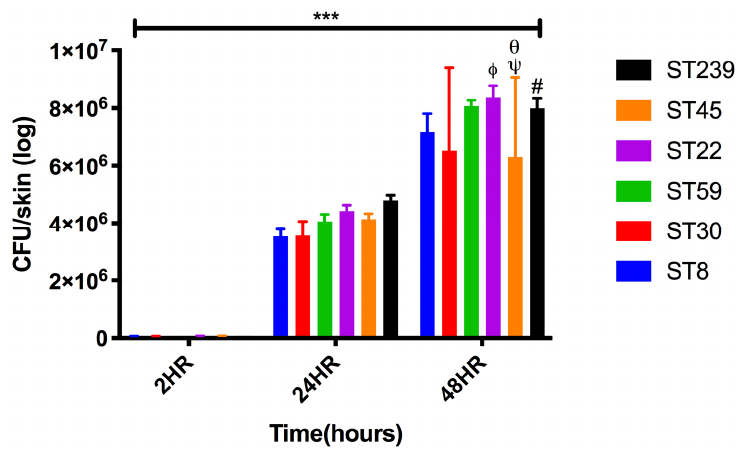
Figure 4. Enumeration of adherent and internalized bacteria of MRSA strains representative of common ST types on skin model. Error bars represent SD of the mean, statistical significance was calculated using two-way ANOVA (*** p < 0.001) and Tukey post hoc test. The p -values are coded with respect to each strain and are derived from the comparison between the means of the two respective strains. p -values were significant at p < 0.05 when compared to ST30 ( φ ), ST59 ( ψ ), ST22 ( θ ), and ST45 (#).